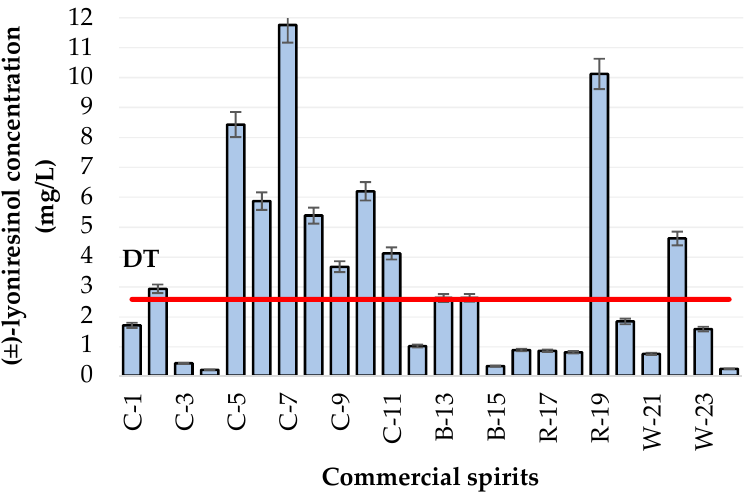
Figure 4. Variations in ( ± )-lyoniresinol content in 24 commercial spirits. The red line represents the level of the gustatory detection threshold (DT).